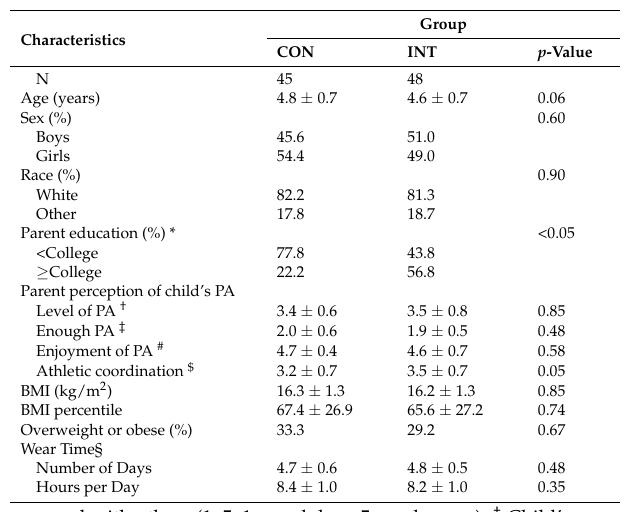
Table 1. Descriptive Characteristics of Participants, Mean ± SD or